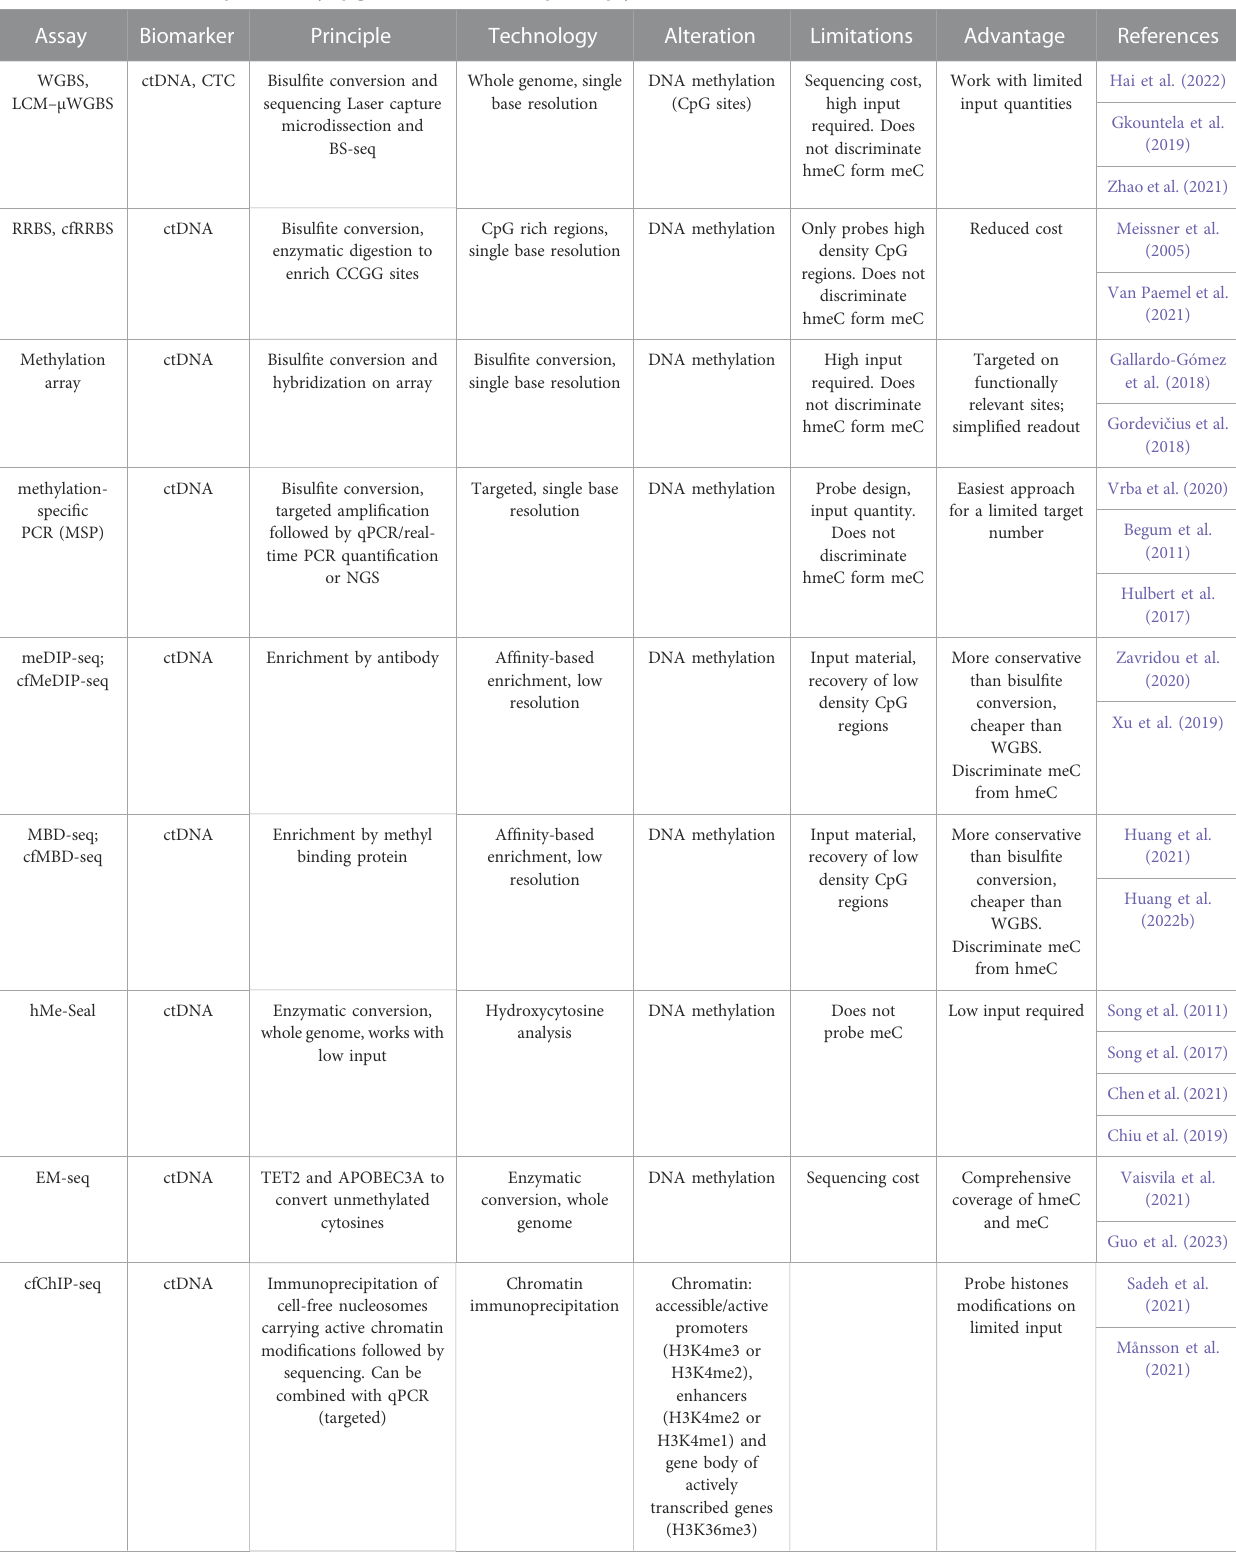
TABLE 4 Overview of techniques to study epigenetic alterations in liquid biopsy.